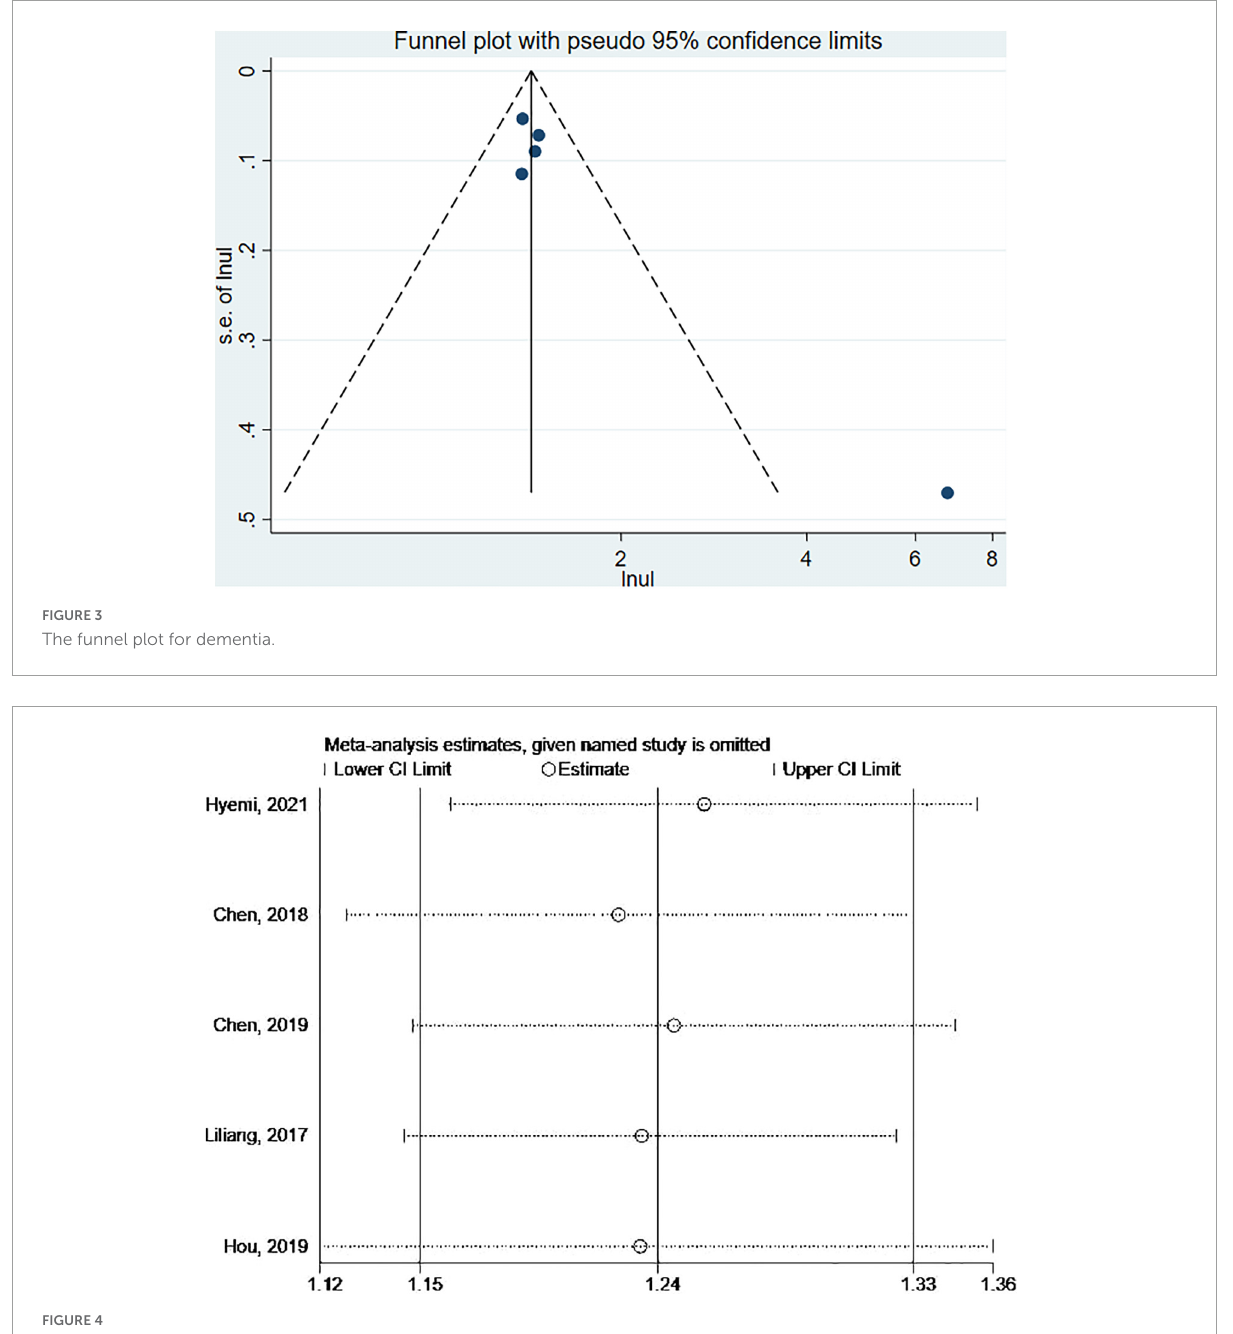
FIGURE4 The sensitivity analysis of the association between SS and risks of